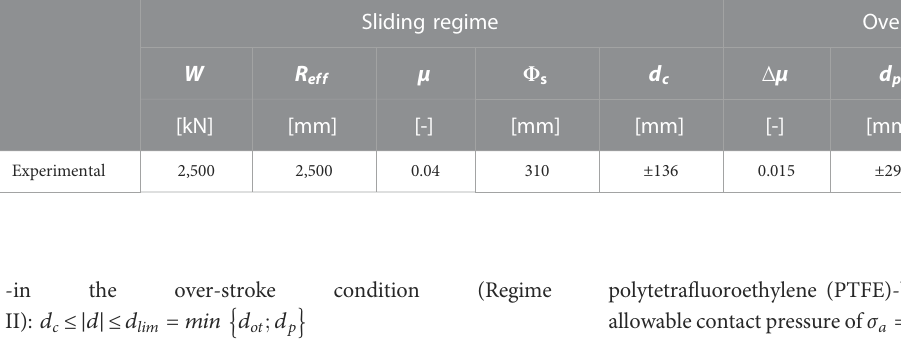
TABLE 1 Main characteristics of the DCCSS specimen and the over-stroke experimental test. Sliding regime Over-stroke